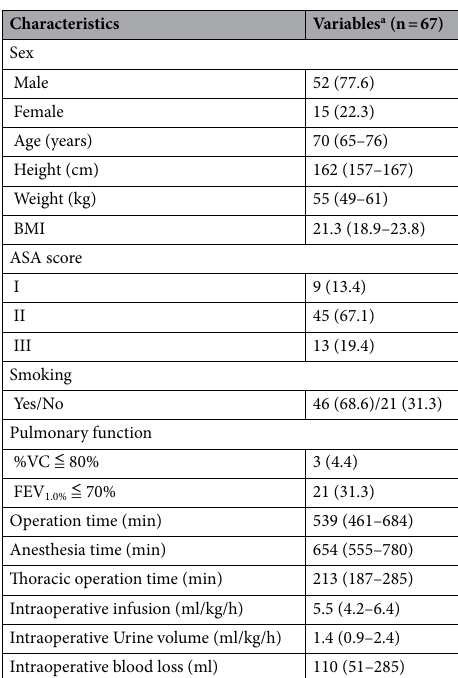
Table 1. Patient characteristics and operative outcomes. ASA, American Society of Anesthesiology; BMI, body mass index; VC, vital capacity; FEV, forced expiratory volume. a Values in parentheses are percentages unless indicated otherwise; continuous values are expressed with median (interquartile range).